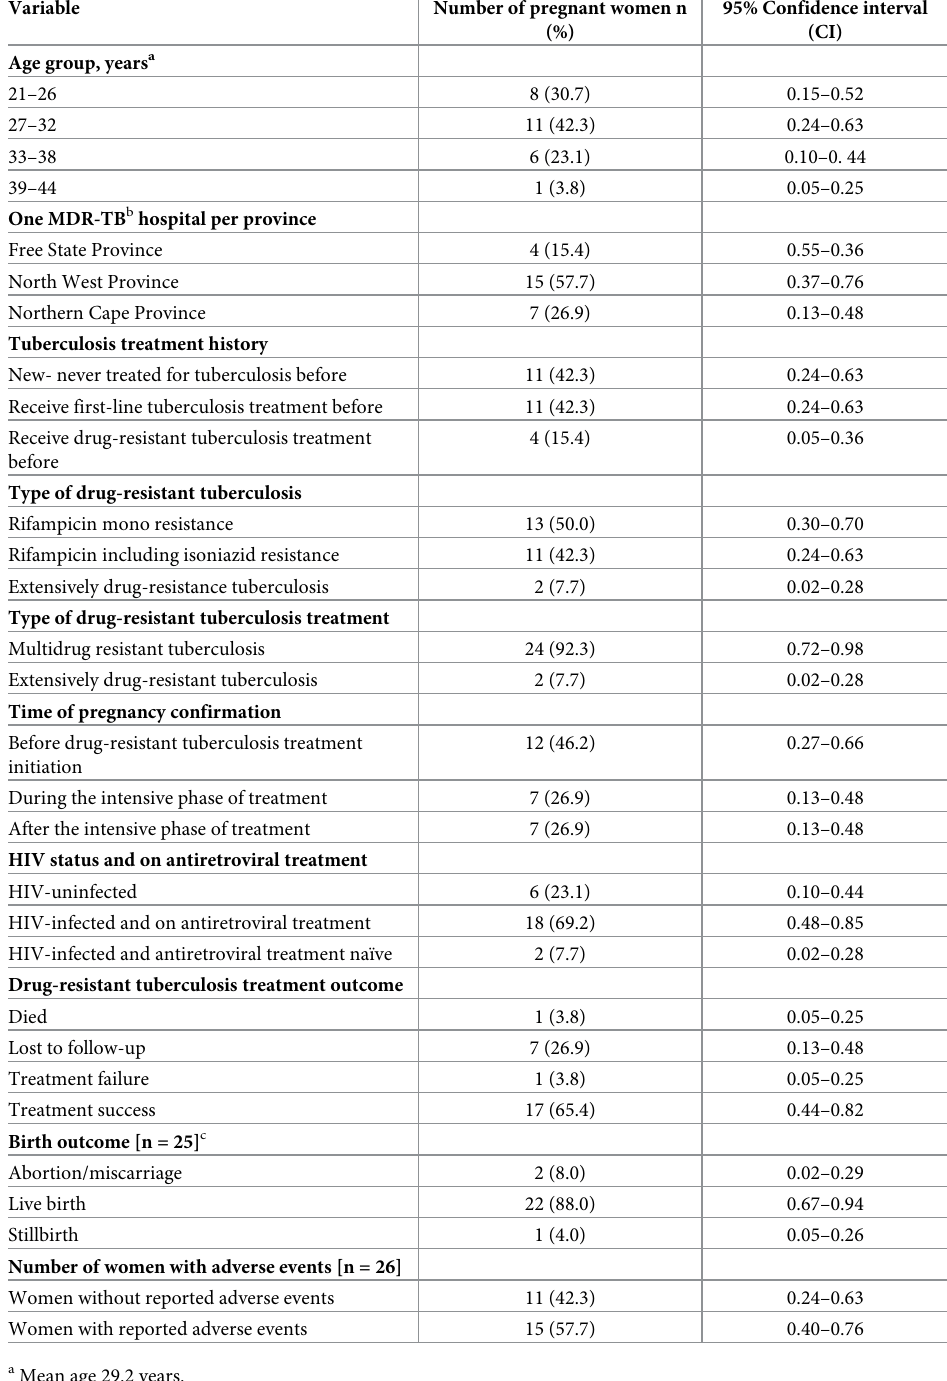
Table 1. Demographic and clinical characteristics of pregnant women (N =